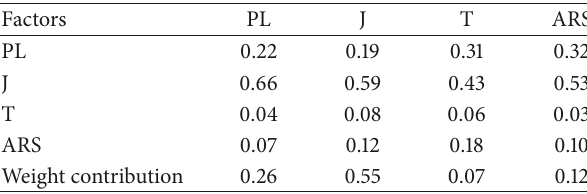
Table 15: Sample calculation of QoE